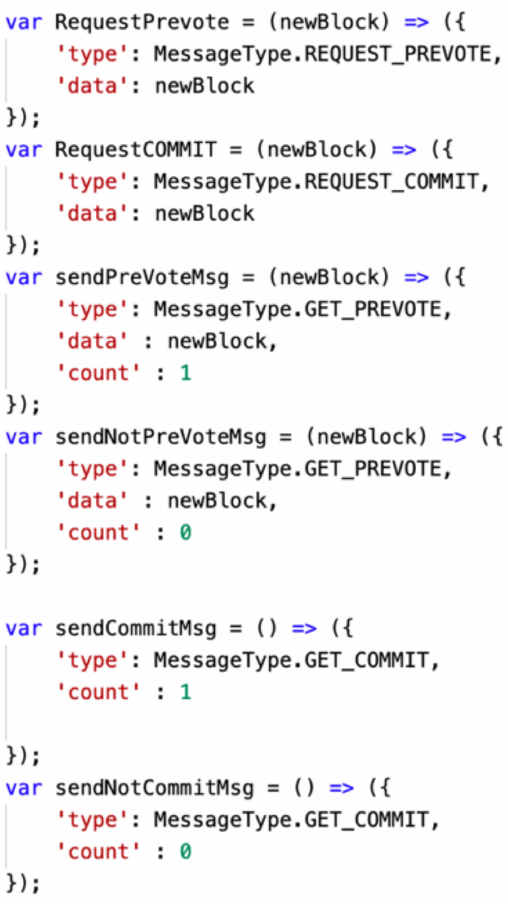
Figure 5. PBFT consensus